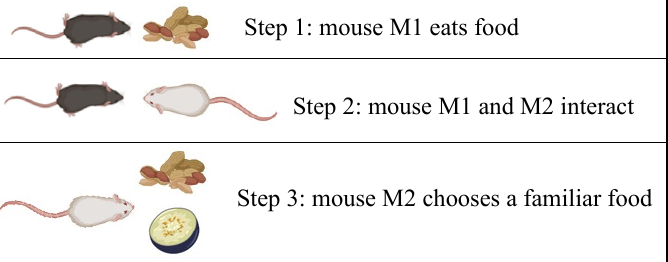
Figure 6. The social transmission of food preference. A classical test to evaluate social transmission of food preference between two mice; mouse M1 encounters the food and transmits information to mouse M2. Created with Biorender.com.